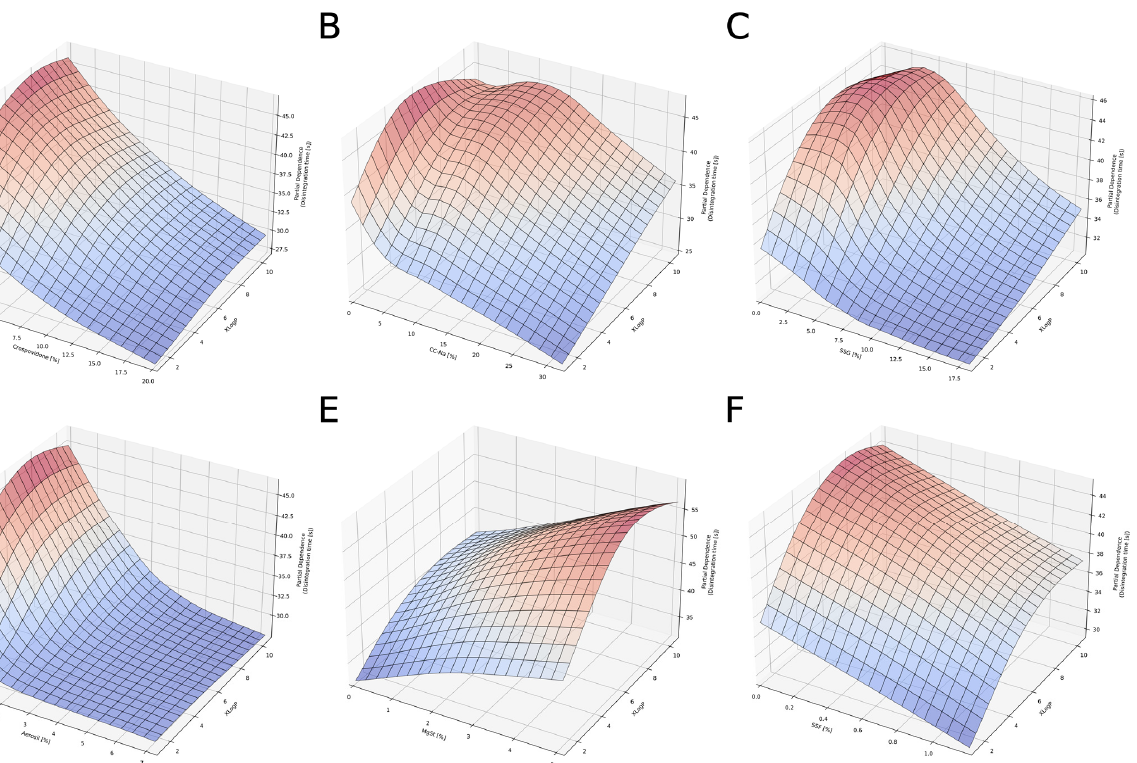
Figure 7. SHAP plots representing the effects of APIs molecular descriptors on disintegration time. GATS7i and GATS7p, the Geary autocorrelation with lag 7 descriptors, weighted by ionization po- tential ( A ) or polarizability ( B ); GGI7, the topological charge index of order 7 ( C ); MATS4p, the Moran autocorrelation of lag 4 weighted by polarizability ( D ); MIC2, a modified information con- tent index, neighborhood symmetry of 2-order descriptor ( E ); XLogP, a theoretical n-octanol– water partition coefficient ( F ).